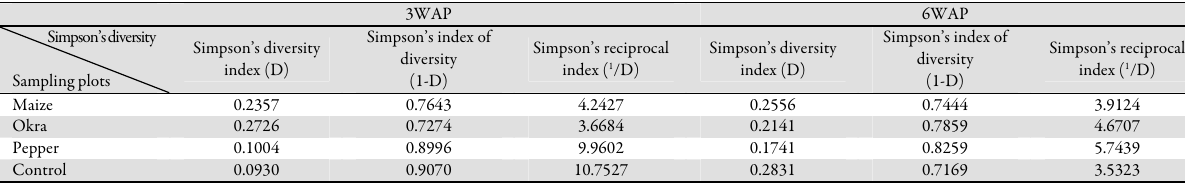
Tab. 9. Weed species diversity at 3WAP and